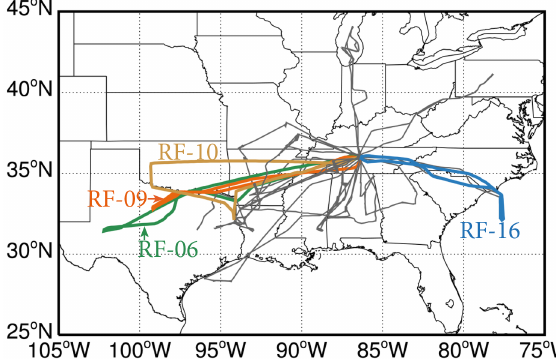
Figure 1. Flight tracks of the NSF/NCAR C-130 aircraft during the 19 NOMADSS research flights between 1 June and 15 July 2013. The flight tracks of four flights discussed in the text are highlighted (RF-06: green, RF-09: red, RF-10: brown, and RF-16: